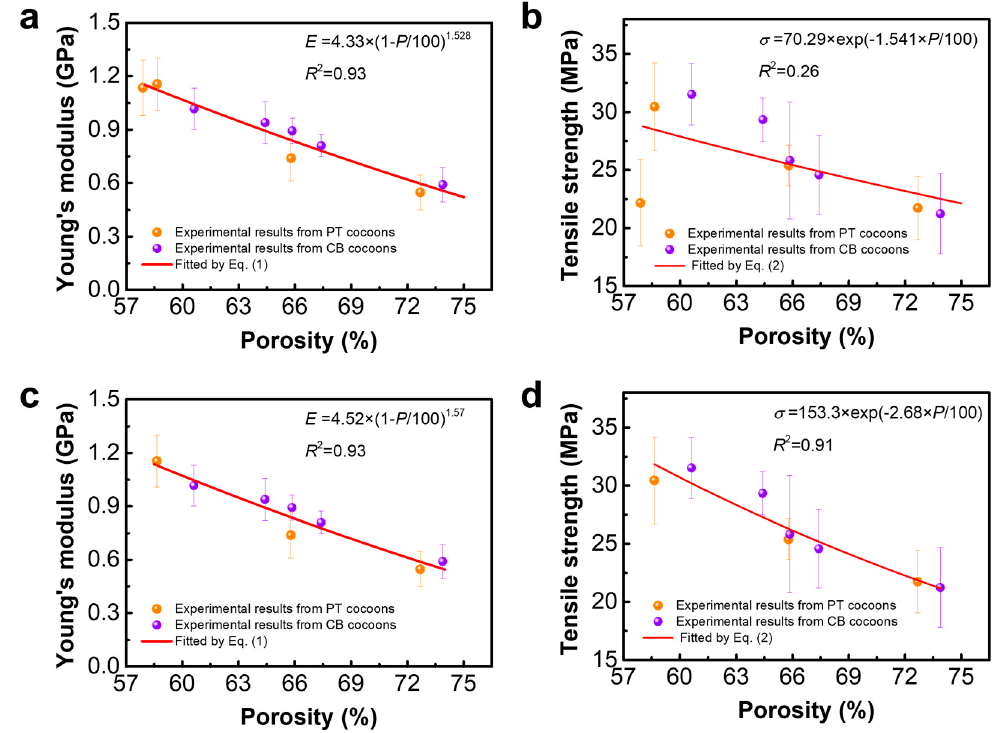
Figure 6. Porosity dependence of ( a ) Young’s modulus and ( b ) tensile strength for all the silkworm cocoons; porosity dependence of ( c ) Young’s modulus and ( d ) tensile strength for the silkworm cocoons without PT-12.